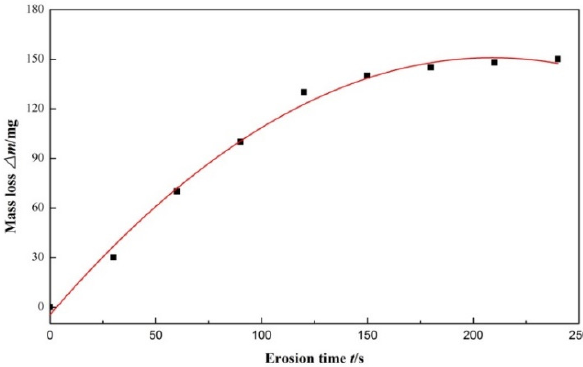
Figure 3. Mass loss as a function of erosion time ( L c / d 1 = 2, D c / d 1 = 8, α = 120°, P o = 20 MPa).